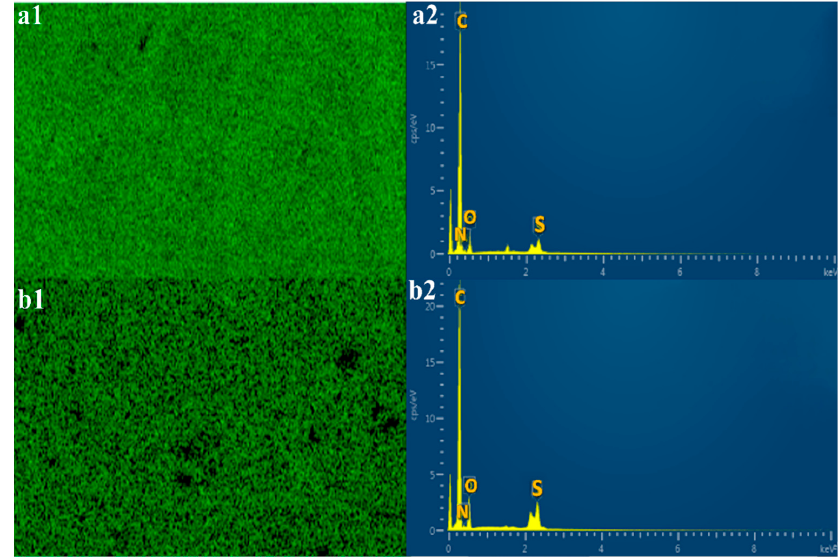
Figure 8. EDX Map and spectra of ( a1 , a2 ) ES-SDIB / PBz-5 with the presence of sulfur (S) (green color) and sulfur peak; and ( b1 , b2 ) ES-SDIB / PBz-10 showing the presence of sulfur (S) (dark green color) and sulfur peak; (scale bar = 5 µ m); Other peaks without label in the spectra are Au used as coating material.